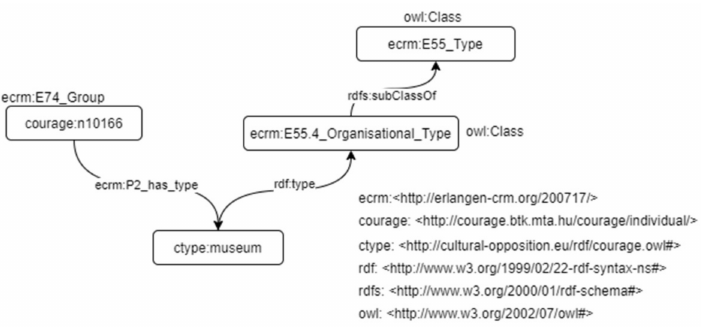
Figure 9. An example of an organizational type representation in